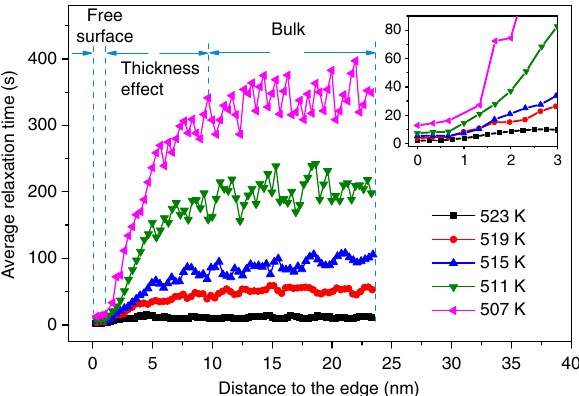
Fig. 3 Near-surface region with fast dynamics. Pro fi les through the τ maps in Fig. 2. Near the free surface, the relaxation time remains almost constant and is about 20 times smaller than in the center of the nanowire. The inset shows that the near free surface layer is 3 – 4 pixels wide, which is between 0.7 and 1 nm. The dependence of τ on the projected thickness of the wire along the pro fi le is discussed in the supplemental information